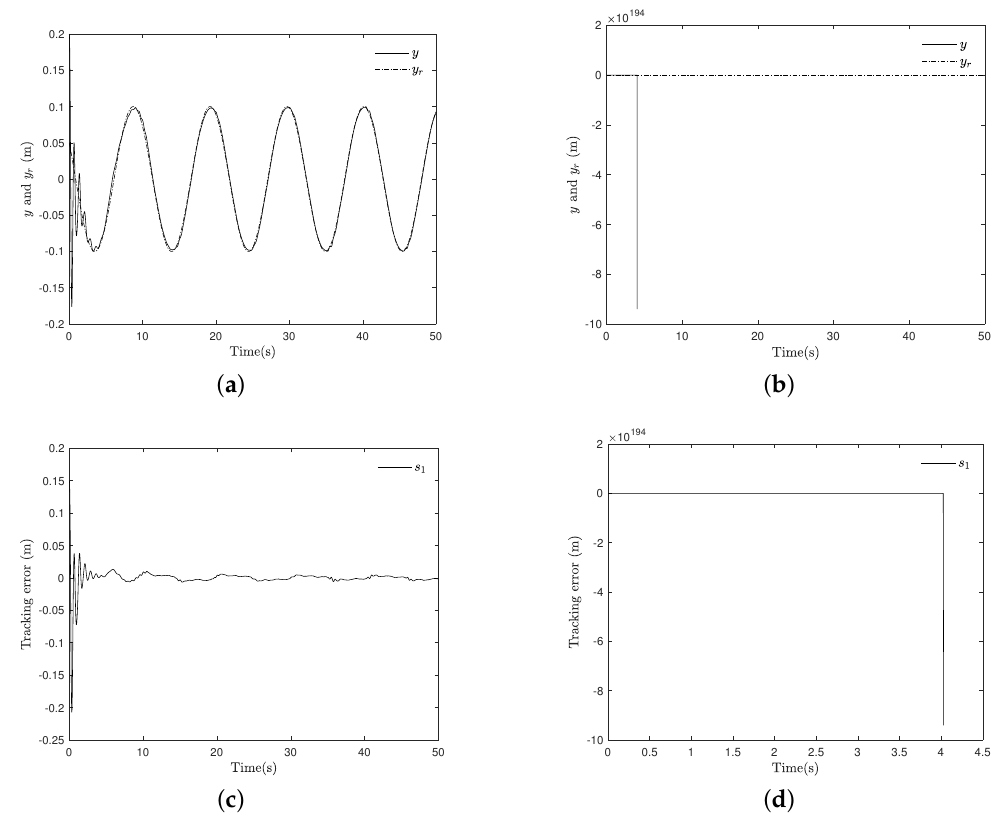
Figure 1. Comparison of tracking results and errors for Example 1: ( a ) y and y r of the proposed control system; ( b ) y and y r of the control system presented in [24]; ( c ) s 1 of the proposed control system; and ( d ) s 1 of the control system presented in [24].